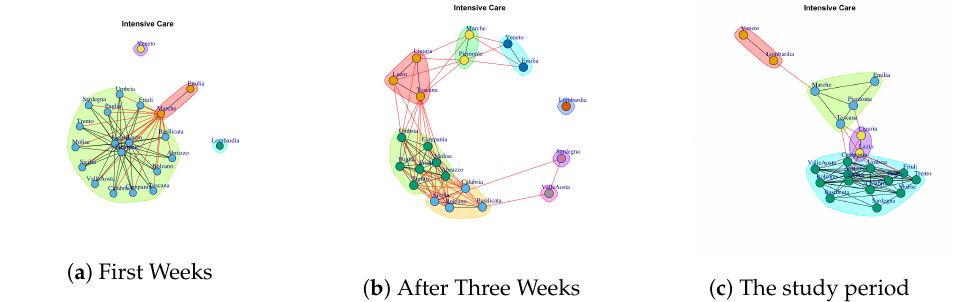
Figure 15. Evolution of Intensive Care Network Communities.